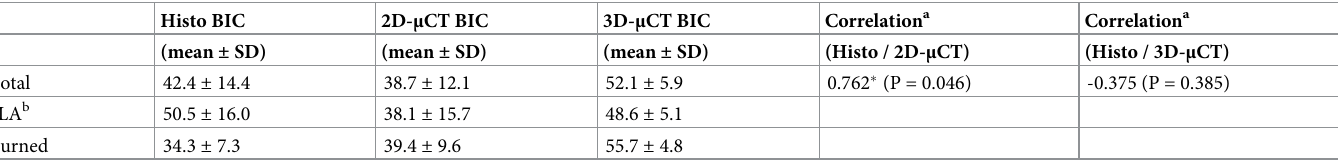
Table 1. Bone-to-implant contact (BIC) ratios of the implants determined using histologic sections, 2D- μ CT, and 3D- μ CT images, and the correlations between the different methods. Histo